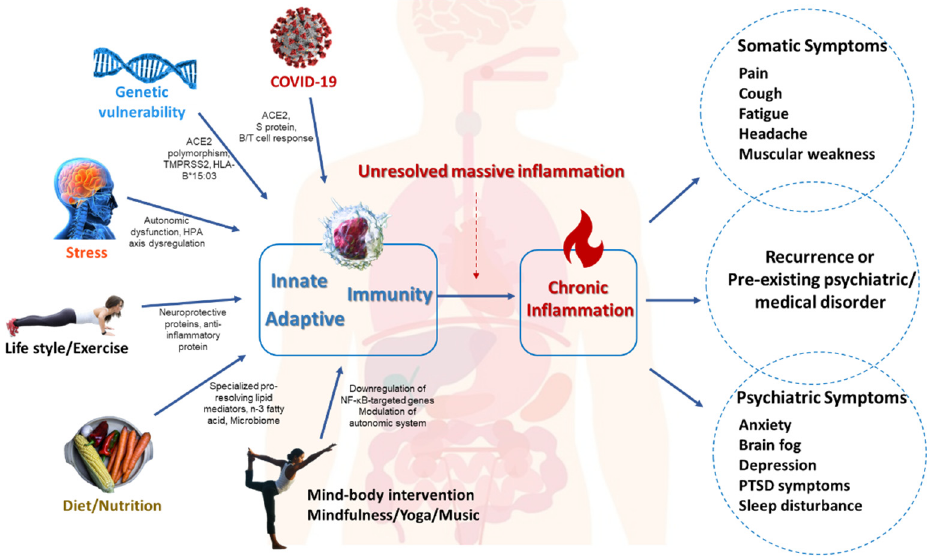
Figure 1. Potential mechanisms linking inflammation theory of MDD to long COVID. ACE2: Angiotensin-converting enzyme 2; HLA-B: Human Leukocyte Antigen-B; HPA: Hypothalamic-pituitary-adrenal; NF-KB: Nuclear factor kappa B.